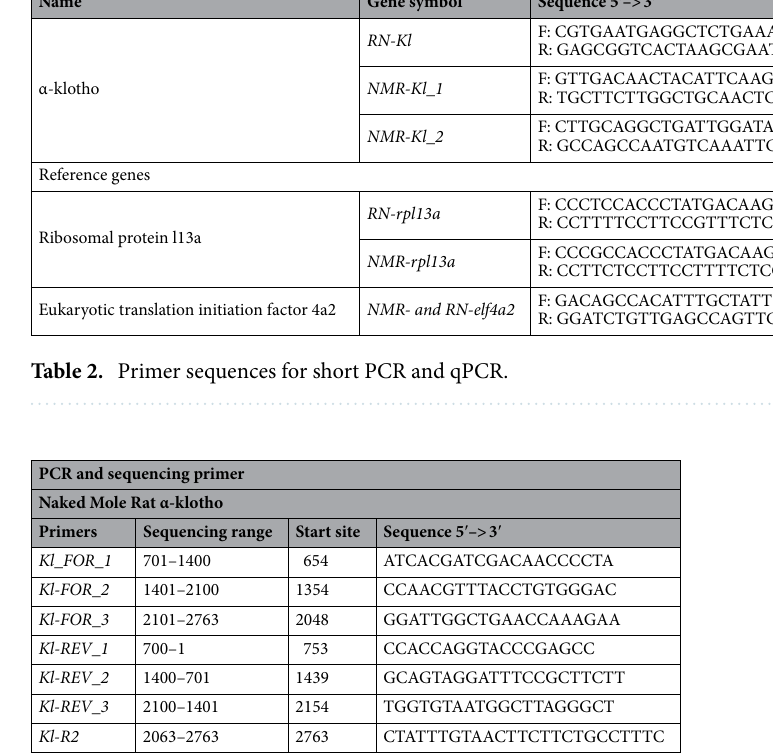
Table 3. Long-range PCR and sequencing